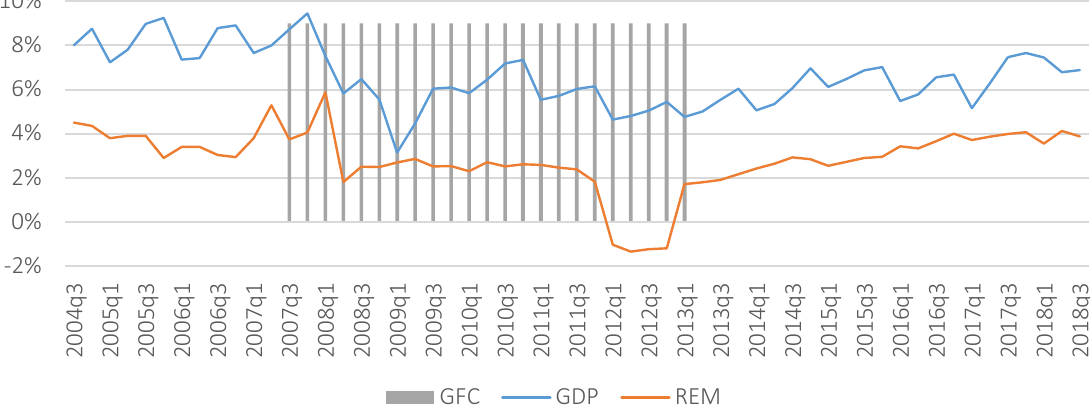
Figure 6. Real estate market (REM), economic growth (GDP), and global financial crisis (GFC)